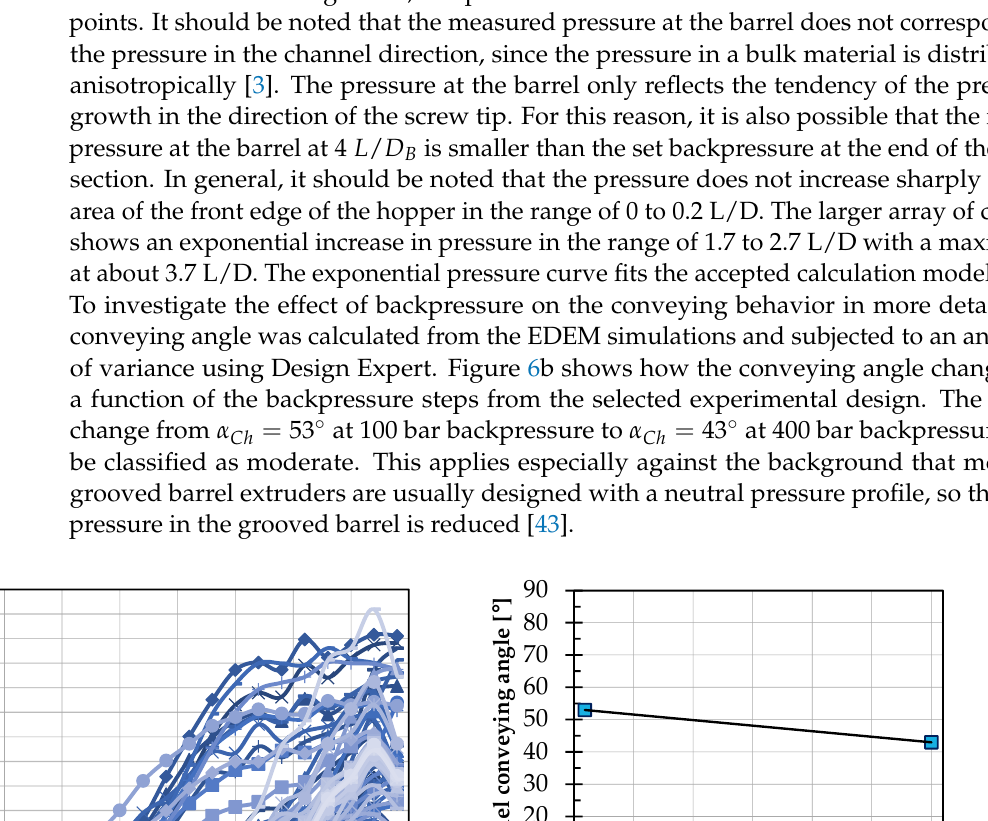
( c ) Figure 7. Conveying angle from the analytical calculation according to Bornemann plotted against the conveying angle from the EDEM simulations, sorted by conveying cases 1a, 1b and 2a. The situation in case 1b, see Figure 7b is much less clear. Of the 25 test points, 8 show a small deviation of well below 20%, 13 deviate slightly more than 20% and 4 deviate strongly. A visual analysis of the latter test points, which are described in detail in [44],